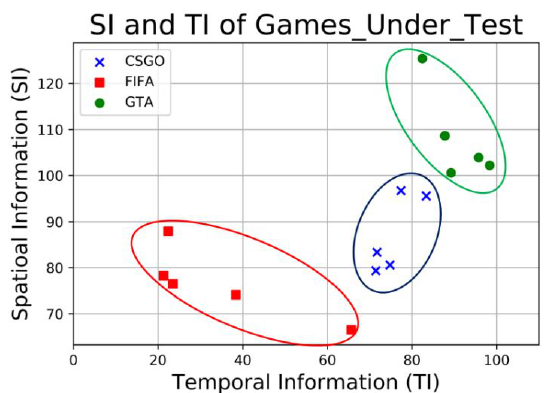
Figure 5. Spatial and Temporal Information results of cloud